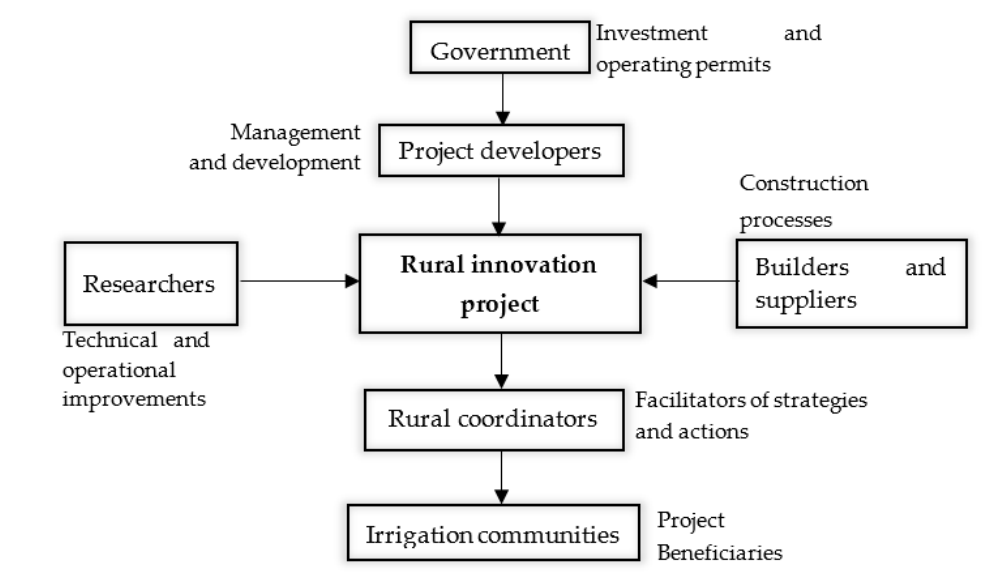
Figure 2. Functions of the main actors involved in the project. Source: Author elaborator.